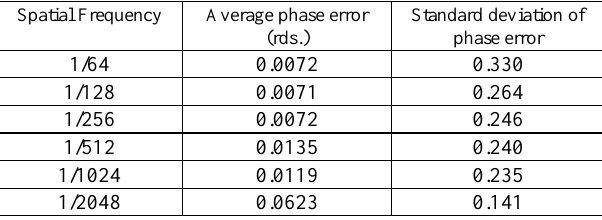
Table 2. Comparison of phase errors with different spatial frequencies